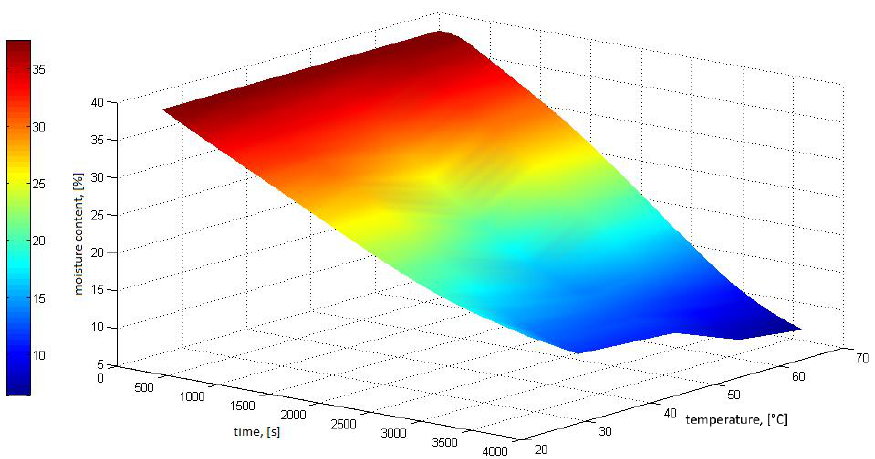
Figure 19. Plane diagram of the drying process, 3D installation; Tur ó w; 0–8 mm; temperature 27–50 ◦ C.